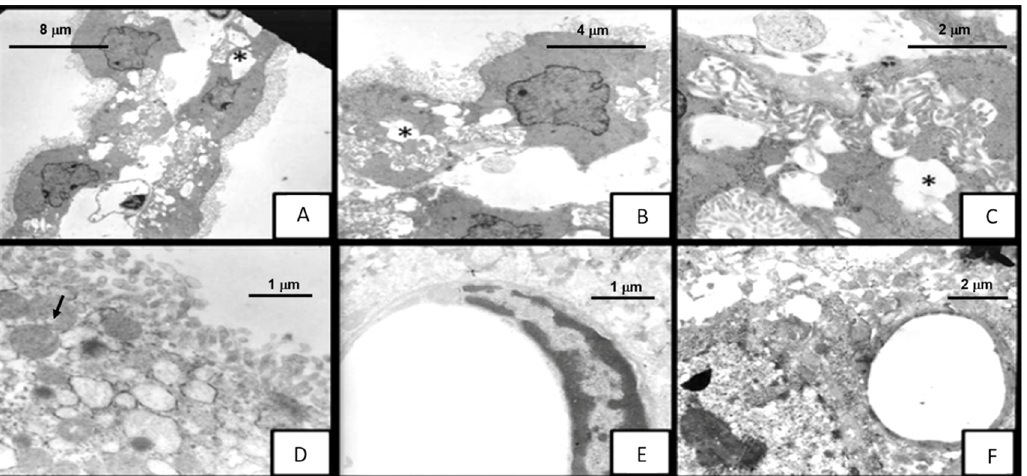
Figure 5. Transmission electron micrograph of brain tissue of mice infected with M. tuberculosis N15 (LAM 3) strain [5] on day 3: the epithelial cells of the choroid plexus with evident alteration of the architecture; vacuolation of the more than 60% of the cell area; enlargement of the interdigitations and separation of the cells *. ( A ) × 2500, ( B ) × 5000, ( C ) × 10,000 ( D ) observed with increased vacuolation and mitochondria alteration (black arrow) × 12,500. ( E ) Frontal cortex blood vessel and × 12,500; ( F ) hippocampus blood vessel ×8000, without alterations of the architecture.